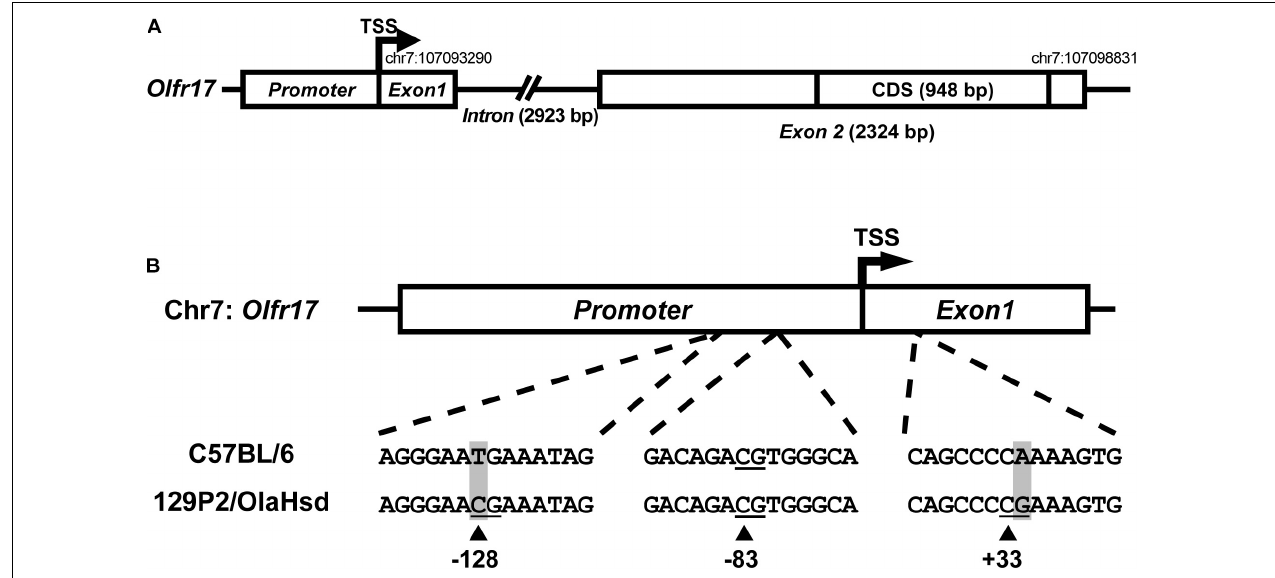
FIGURE 2 | Sequence variation in the 5 (cid:48) regions of the 129 and B6 Olfr17 alleles. (A) Schematic representation of the Olfr17 gene structure. The olfactory receptor gene Olfr17 contains two exons, and the second exon contains the complete coding sequence (CDS) of the gene. The genomic coordinates are according to the GRCm38/mm10 assembly and display the positions of the transcription start site (TSS) and of the last nucleotide within the 5 (cid:48) -UTR. The presumed promoter region is indicated. (B) Schematic representation of the 5 (cid:48) region of the Olfr17 gene of the B6 and 129 mouse strain alleles showing the positions of the CpG dinucleotides. There are two single nucleotide polymorphisms (SNPs) in this region which lead to the generation of two additional CpGs in the 129 Olfr17 allele (at positions –128 and